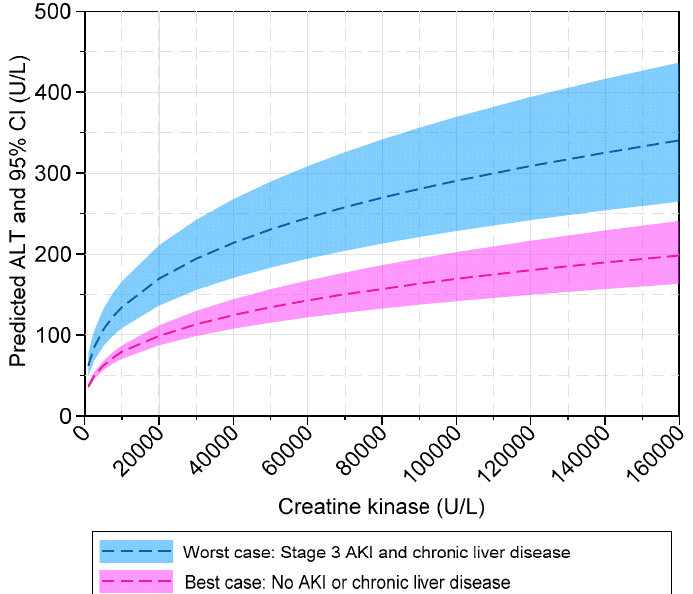
Figure 4. Model of predicted serum ALT in rhabdomyolysis. The multiple regression model was used to generate predicted levels of alanine aminotransferase (ALT) and associated 95% confidence intervals, based on peak creatine kinase, adjusted for acute kidney injury (AKI) stage and chronic liver disease status. Two prediction bands are represented, showing the best-case scenario (pink) and worst-case scenario (blue). The predictions were estimated while holding age constant at the group mean of 66 years.